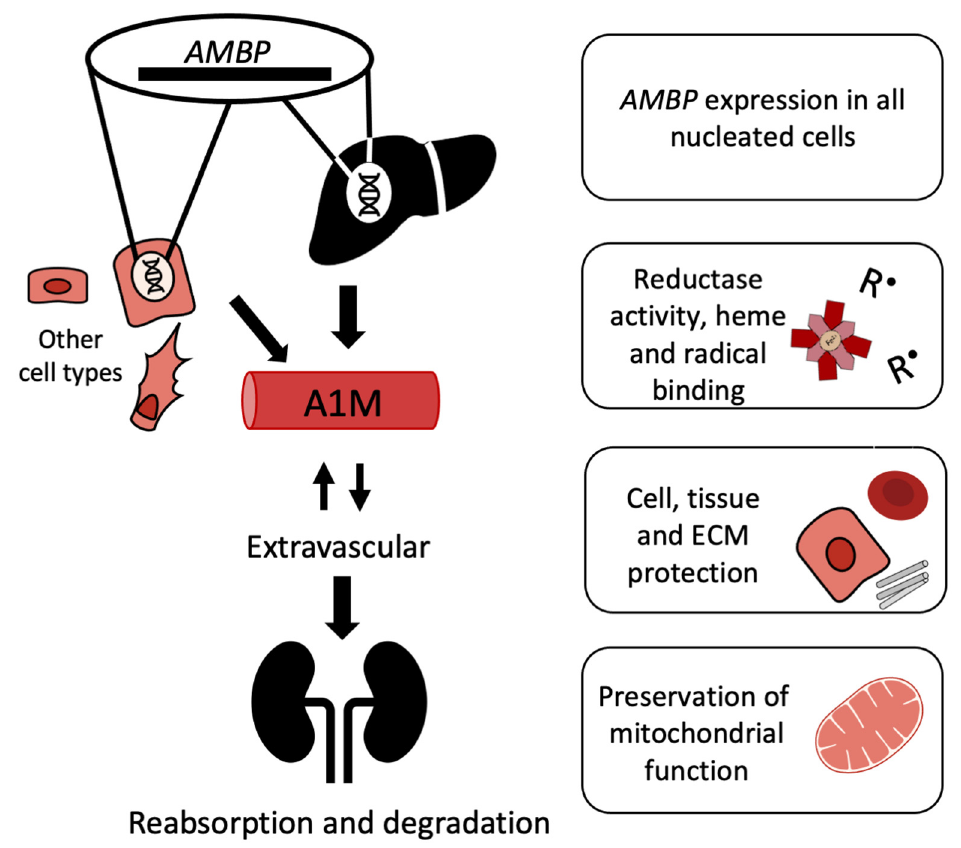
Figure 3. Lifecycle of A1M. Regulation of AMBP expression occurs through the Nrf2-pathway and possibly other pathways. Expression occurs in all nucleated cells and increases in response to heme or oxidative stress. The liver is the main site of synthesis, but other cell types also express AMBP . A1M is extravasated from the bloodstream and can also be internalized into cells. The antioxidant A1M has reductase activity; can bind heme and radicals; protect cells, tissue, and ECM components; and preserve mitochondrial function. A1M passes through the glomerular membrane and is catabolized in the kidneys.